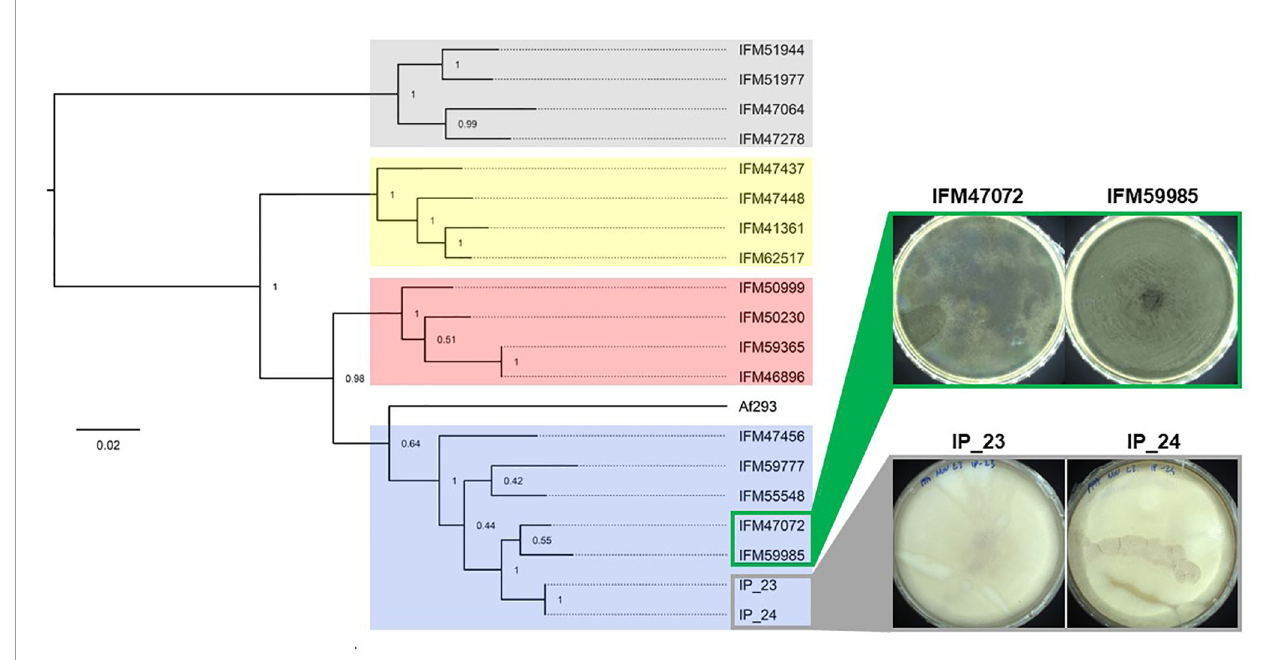
FIGURE 1 | Phylogenetic relationship of white-spore isolates IP_23 and IP_24. Maximum likelihood phylogenetic tree of 7,386 SNVs. The tree is rooted at the midpoint and bootstrap values are provided at each node. Colored clades represent population structure assignments as previously described (Zhao et al., 2021). IP_23 and IP_24, which produce white spores, and IFM4702 and IFM59985, which produce green spores, are members of population 1. Isolates were grown on potato dextrose agar for 7 days at 37°C for